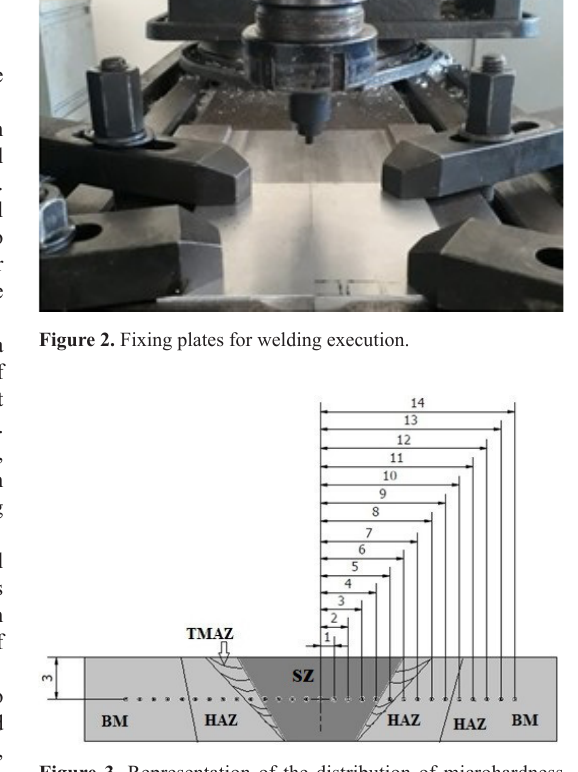
Figure 3. Representation of the distribution of microhardness indentations (dimensions in